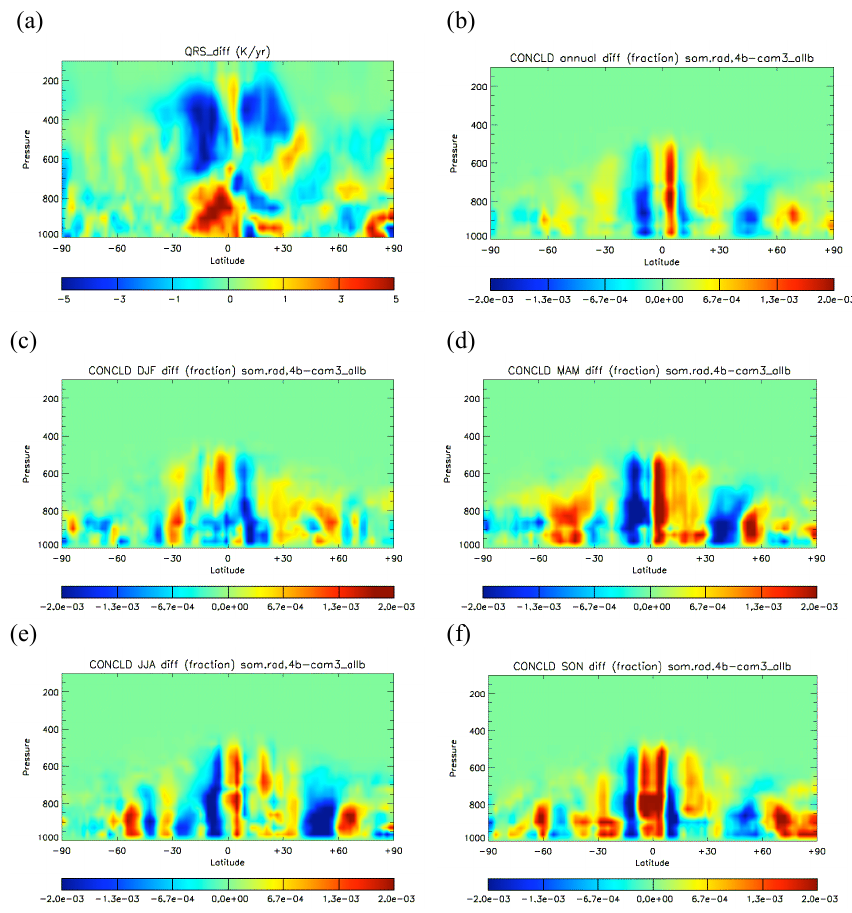
Fig. 11. Vertical cross-section of zonal and annual means of differences in: (a) solar heating rates (QRS) and (b) convective cloud fraction (CONCLD) due to the seasonality of BBCA emissions. Vertical cross-section of zonal and seasonal means of differences in convective cloud fraction (CONCLD) in: (c) DJF, (d) MAM, (e) JJA, and (f) SON, due to the seasonality of BBCA